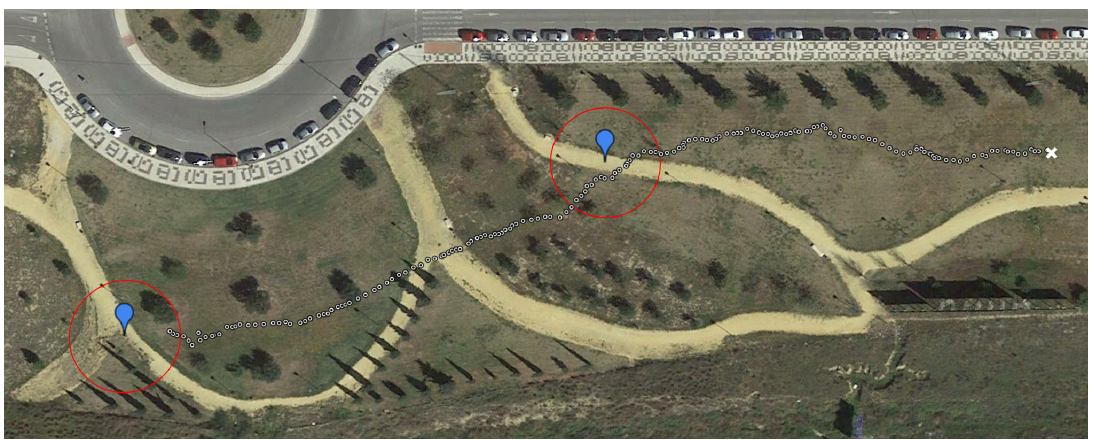
Figure 16. GPS positions of Andabata during navigation (top view).